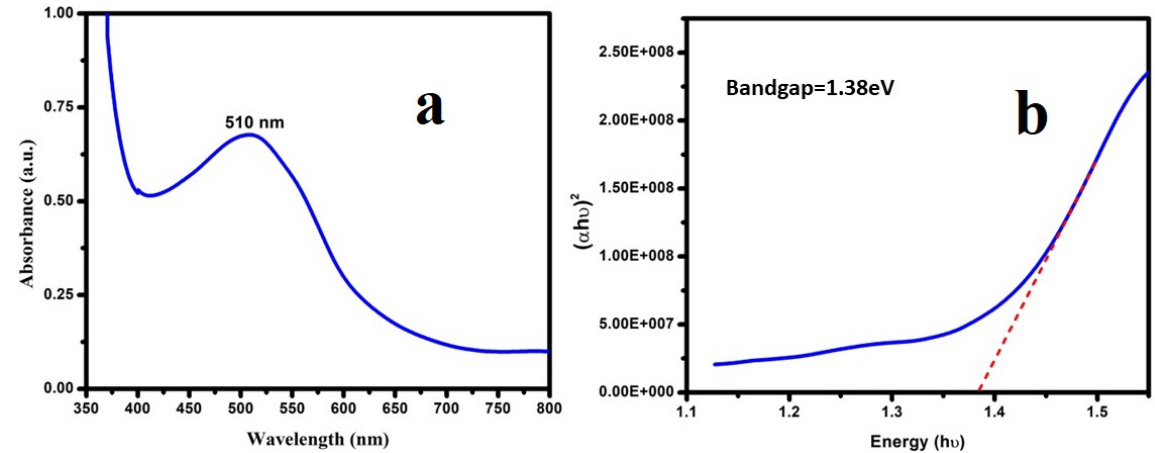
Figure 4. ( a ) UV-visible absorption spectrum and ( b ) bandgap energy of as-prepared PNA